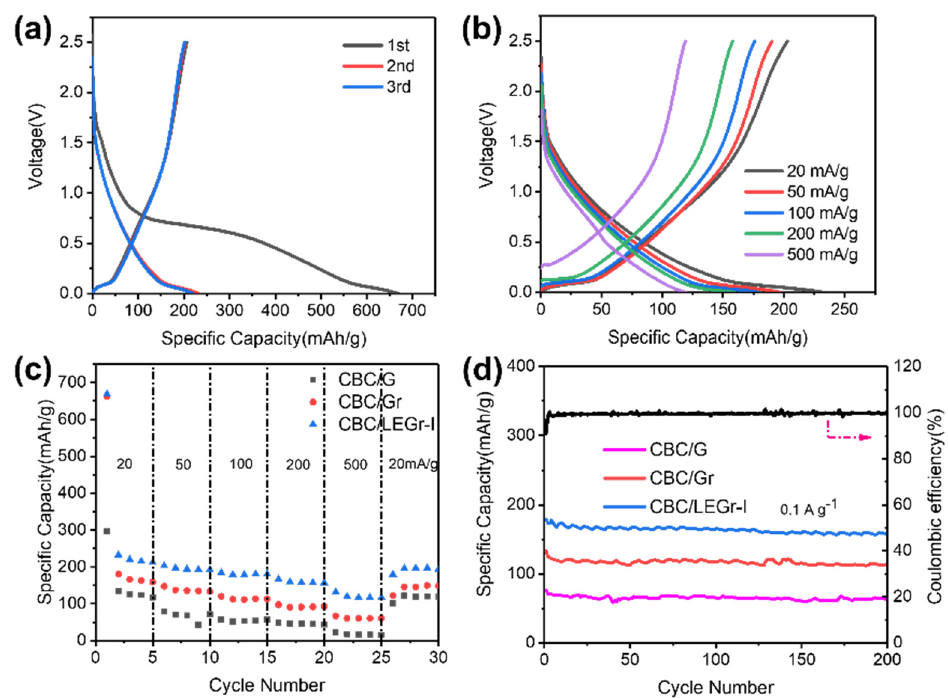
Figure 4. Galvanostatic charge/discharge curves of CBC/LEGr-I ( a ) for first three cycles at 0.02 A g − 1 ( b ) at different rates. ( c ) Rate capacity at different rates and ( d ) cycling stability at 0.1 A g − 1 of CBC/G, CBC/Gr, and CBC/LEGr-I.